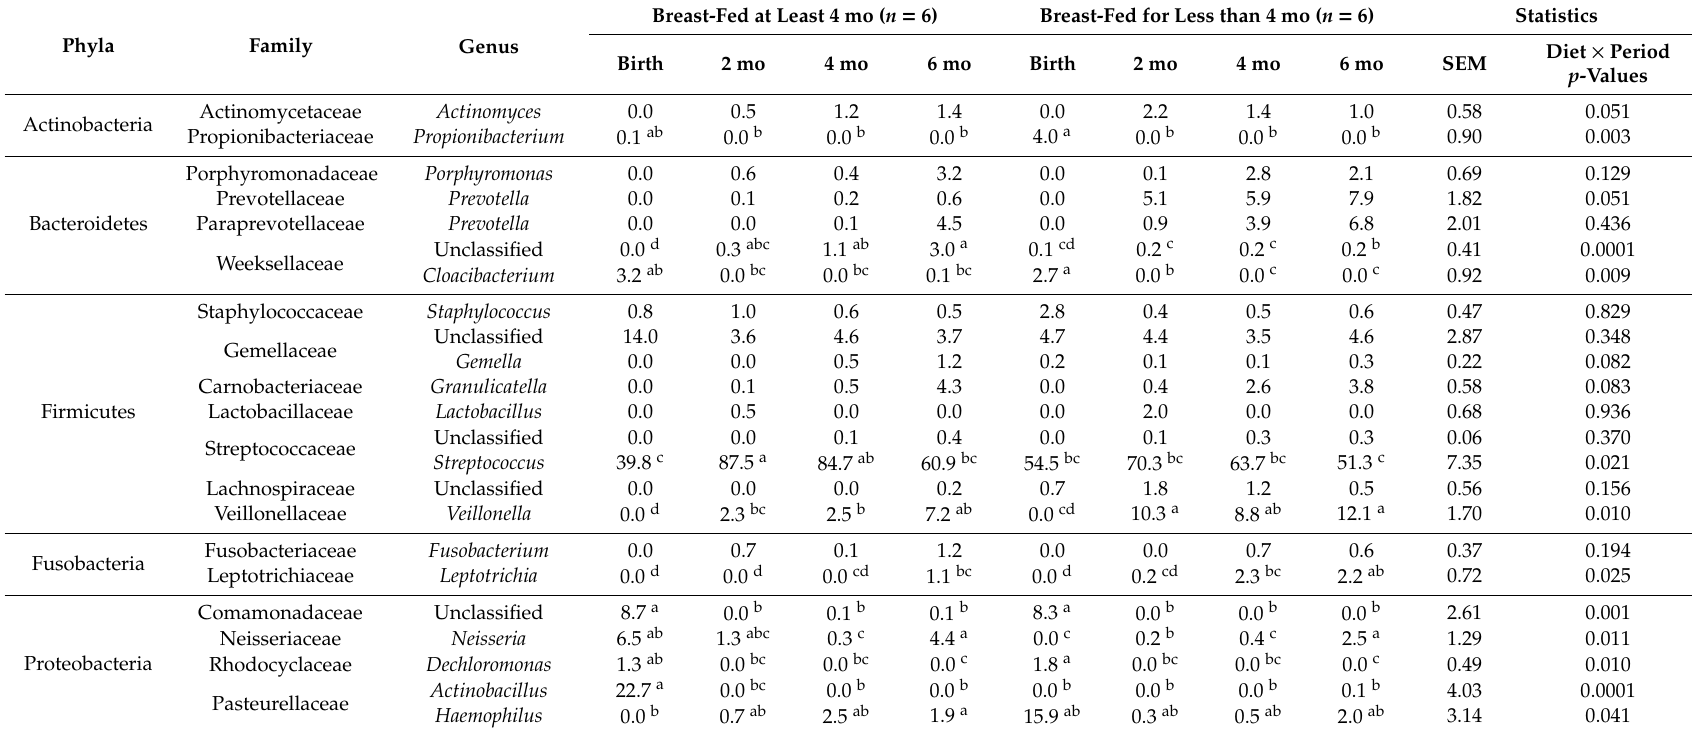
Table 5. Oral bacterial genera of infants by age and duration of breast feeding (% of